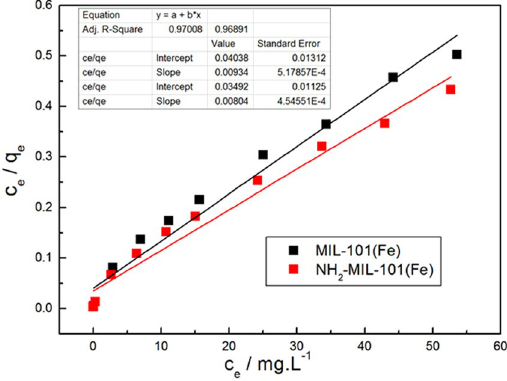
Figure 11. Langmuir plots of the isotherms for phosphate adsorption on Fe-based MIL-MOFs ( Adsorbents, 12 mg; NaH